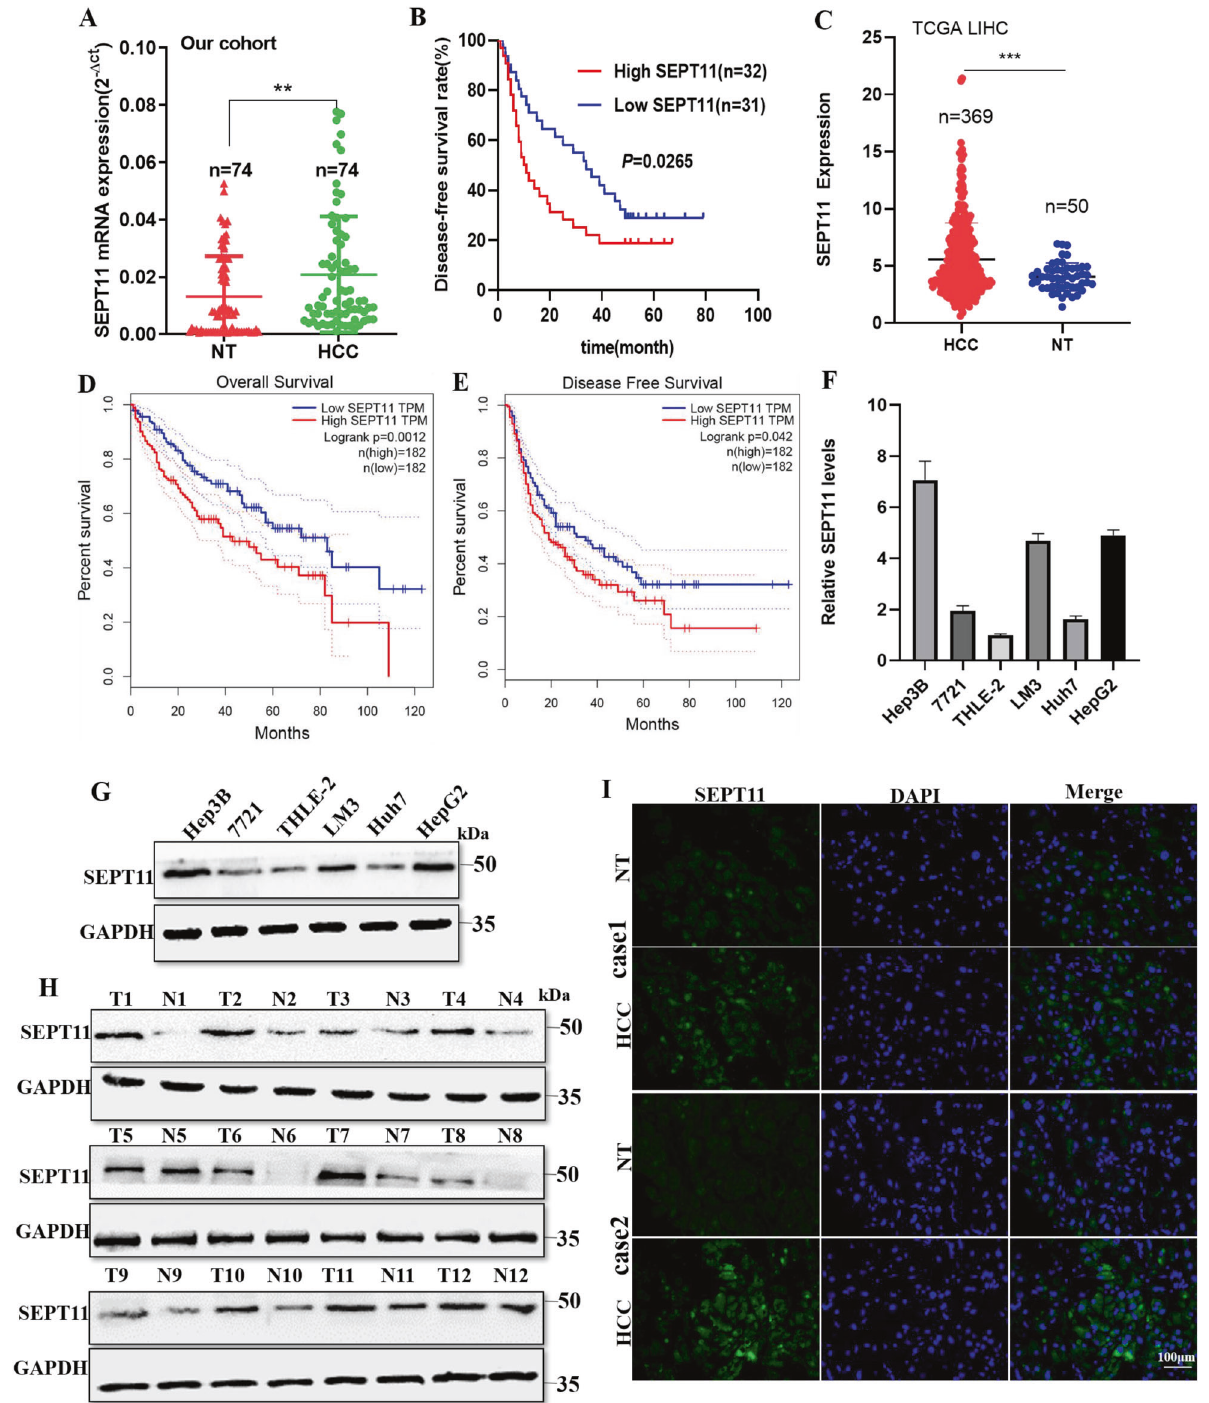
Fig. 2 The expression of SEPT11 in HCC was detected by bioinformatics analysis and biological experiments, and its relationship with prognosis was analyzed. A QPCR detection of SEPT11 expression in 74 patients with HCC paired cancer and paracancerous tissues; B the relationship between SEPT11 expression and prognosis DFS in 74 patients with HCC; C The expression of SEPT11 in tumor and adjacent tissues was analyzed by TCGA database data; D , E The relationship between SEPT11 expression and prognosis of OS and DFS was analyzed by using TCGA database data; F , G QPCR and WB were used to detect the transcriptional expression and protein content of SEPT11 in hepatocytes THLE-2 and HCC cells Huh7, HCCLM3, HepG2, and Hep3B; H WB was used to detect the expression of SEPT11 in paired cancer and adjacent tissues ( n = 12); I Immuno fl uorescence staining was used to observe the expression of SEPT11 in paired cancer and adjacent tissues.